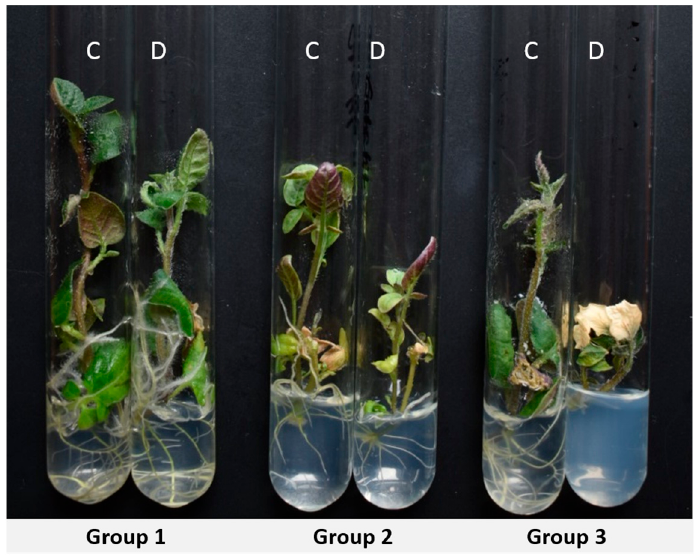
Figure 1. Illustration of morphological differences between members of the three groups after three weeks on 5% PEG media. C—control; D—drought-stressed plants. The representative genotype of Group 1 is DkS10.13, of Group 2 is DeDN11.29, and of Group 3 is DkDN11.26. The analyzed genotypes responded differently to the induced drought stress;